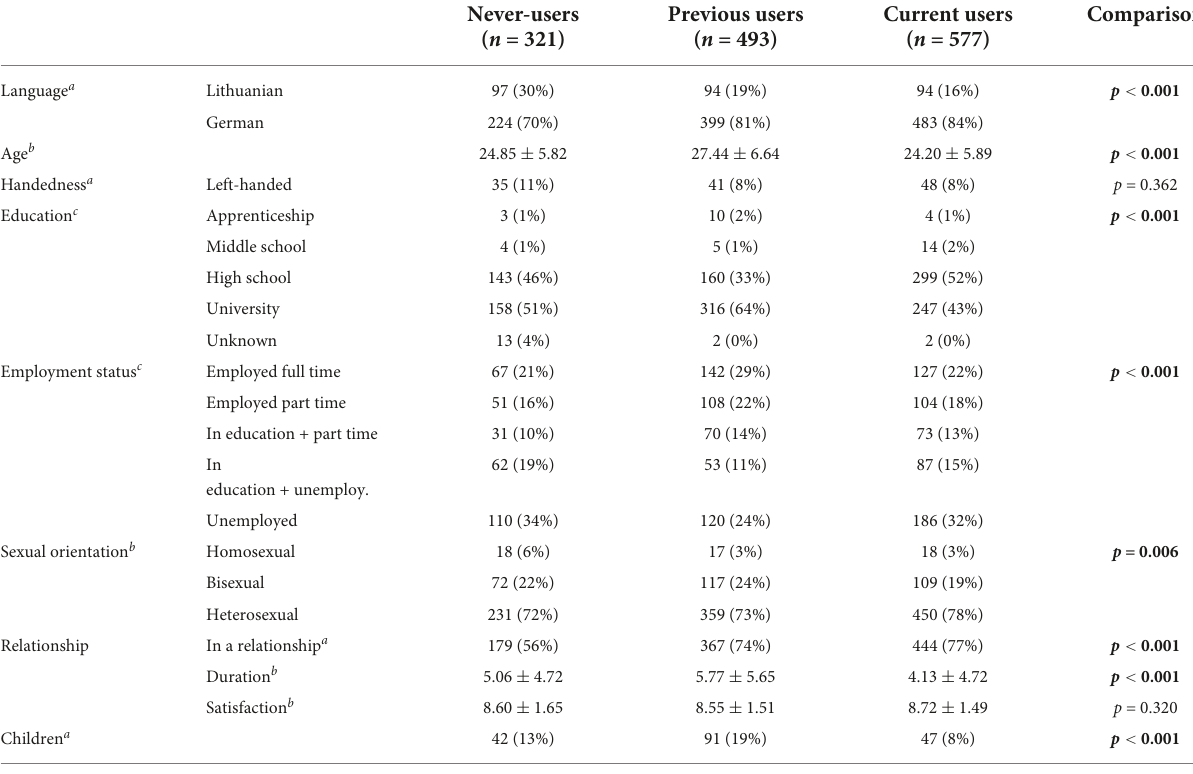
TABLE 1 Comparison of demographic variables between current and previous HC-users and never users prior to